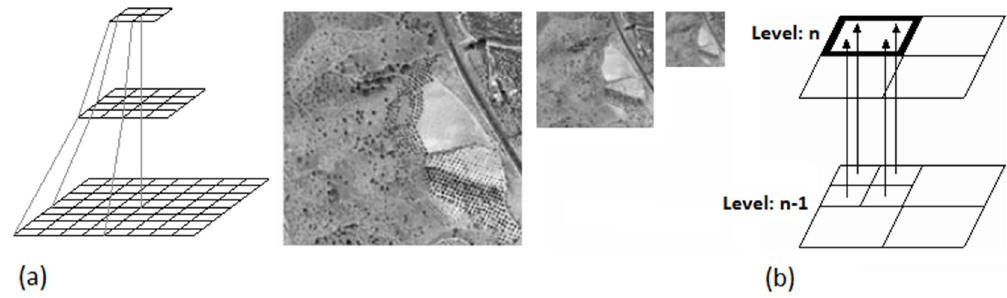
Figure 6. Hierarchical structure. ( a ) Set of pyramidal structures from texture; ( b ) parent link.